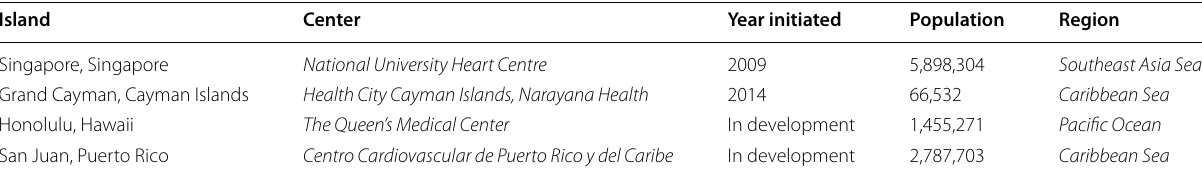
LVAD left ventricular assist device